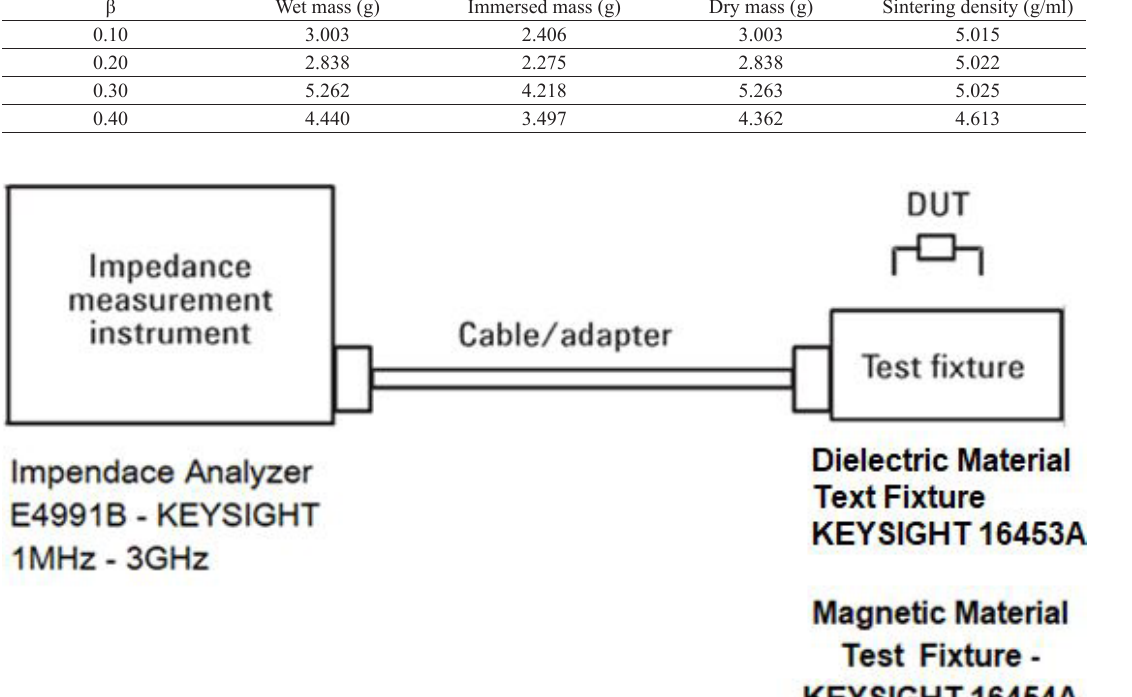
Figure 2. Experimental arrangement for impedance measurements 20-22 .